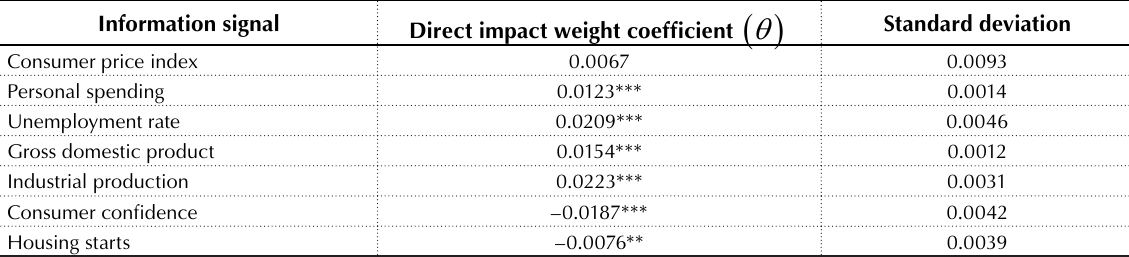
Table 7. The influence of the component of “surprise” on non-monetary information signals of the USA on the volatility of stock prices of enterprises of Ukraine in the economic sector